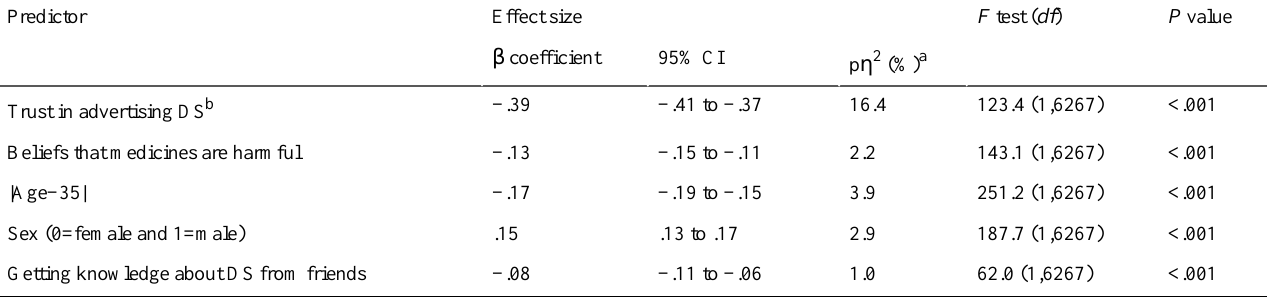
P value F test ( df )Effect sizePredictor